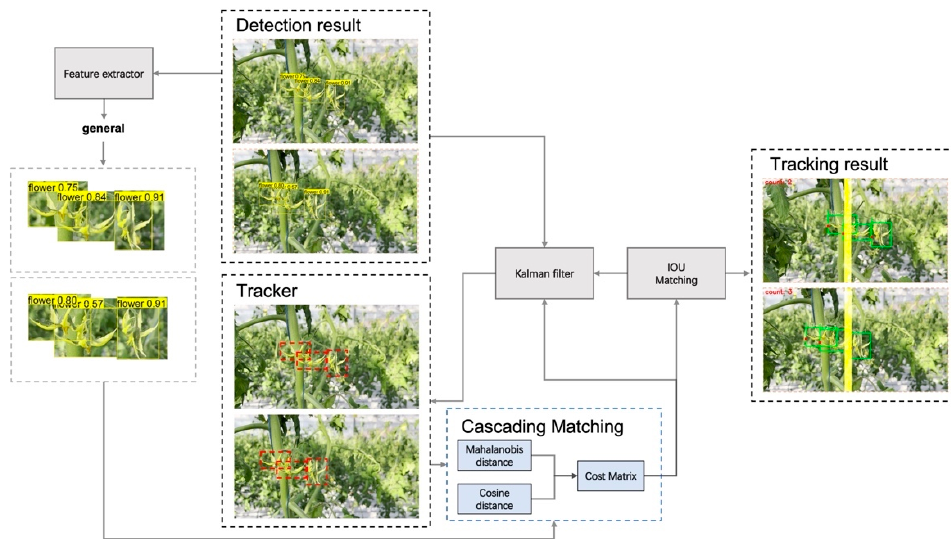
Figure 12. The framework of object tracking.